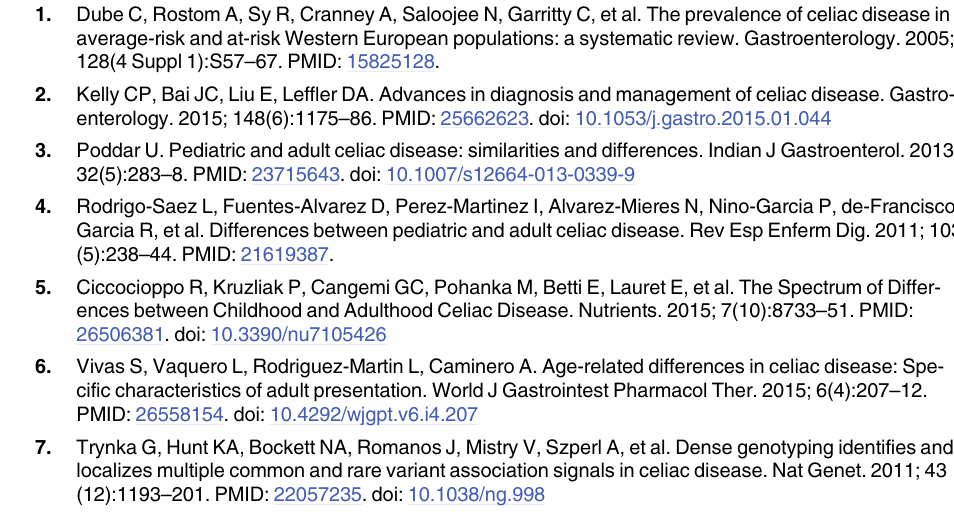
S1 Table. List of the studied genes with the corresponding TaqMan assays